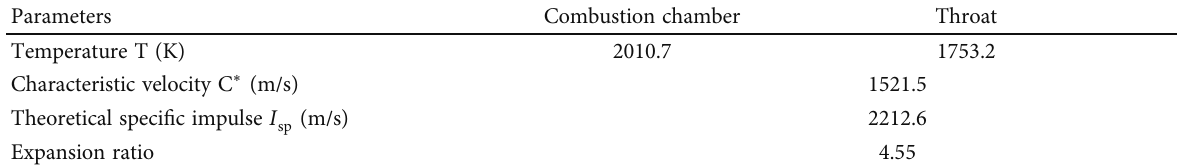
Table 2: Thermodynamic parameters of the thrust chamber in pretest